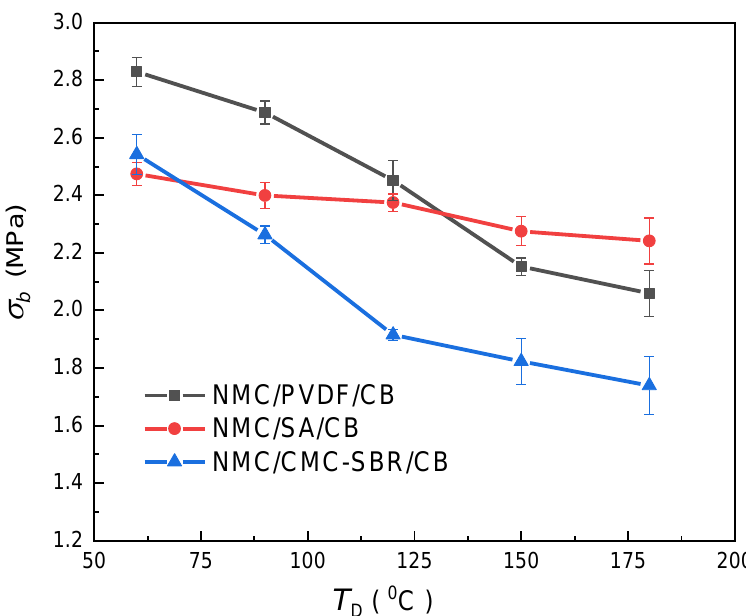
Figure 7. Effect of drying temperature on tensile strength of dried NMC electrode composites.